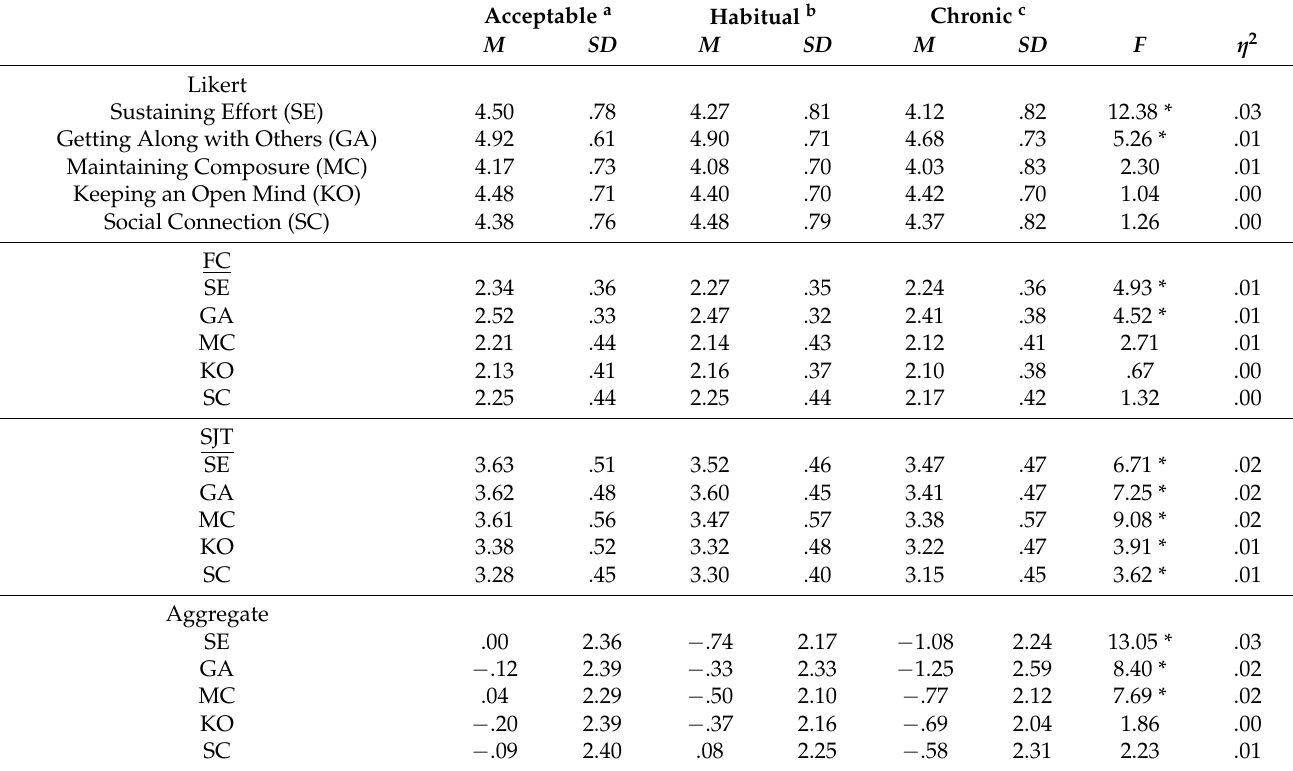
Table 4. Mean Differences on Mosaic Skills Between Students with Acceptable, Habitual, and Chronic Absentee Records in High School